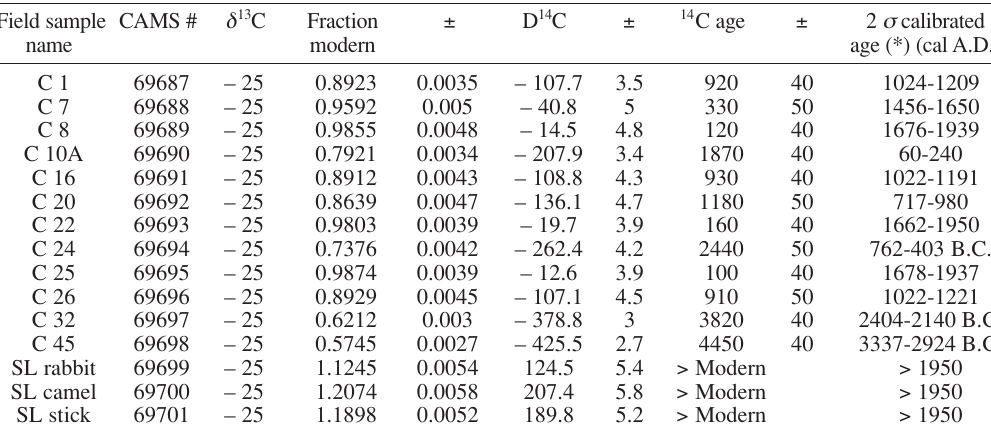
Table I. 14 C data for the Camel paleoseismic site. All analyses are standard AMS dates from CAMS facility at LLNL. (cid:98) . 13 C values are the assumed values according to Stuiver and Polach (1977). Values measured for the material itself are given with a single decimal place. The quoted age is in 14 C years using the Libby half life of 5568 years and following the conventions of Stuiver and Polach (1977). 14 C concentration is given as fraction modern, D 14 C, and conventional 14 C age. Field sample CAMS # (cid:98) . 13